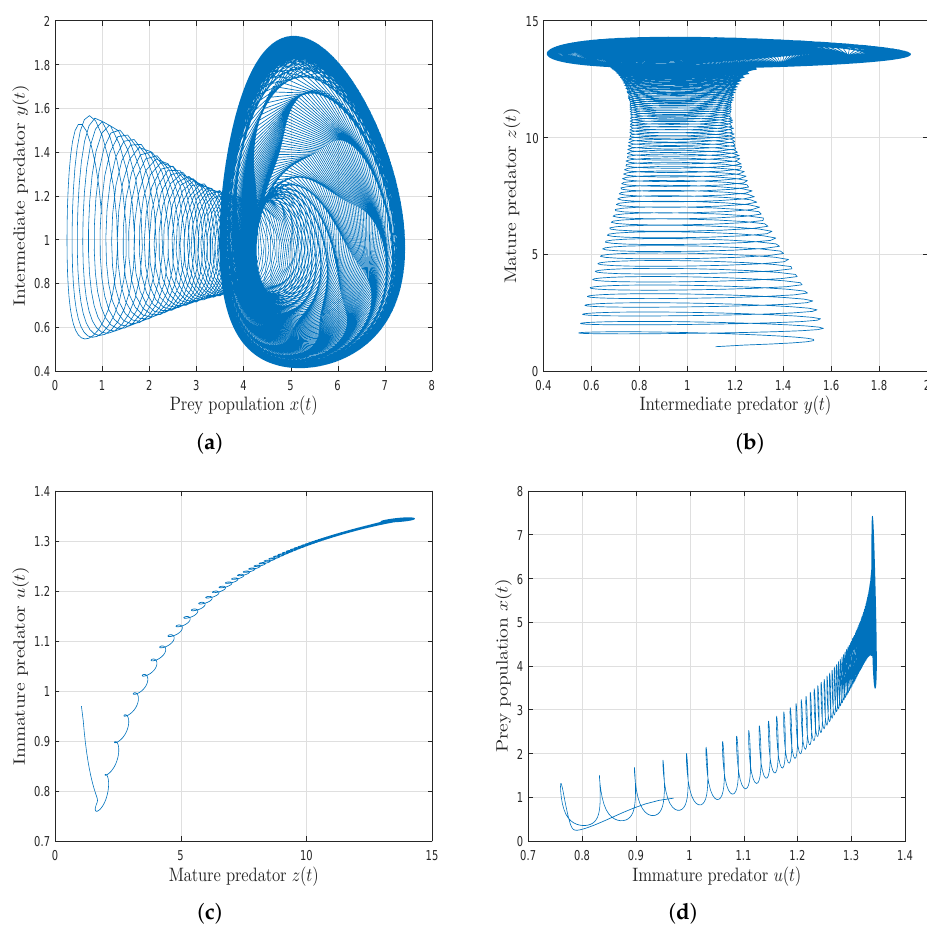
Figure 5. Two-dimensional chaotic phase plot for food web mathematical System (13) with general- ized Caputo fractional operator when ϕ = 1 and ρ = 1.2.